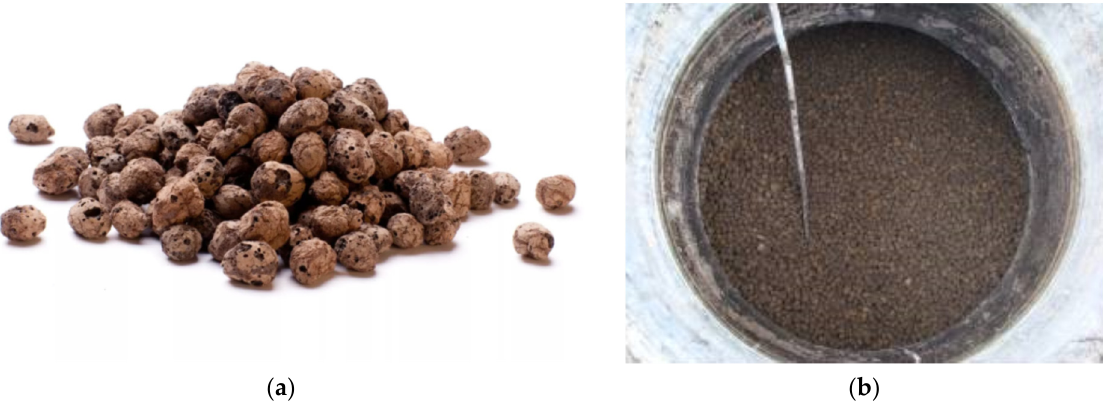
Figure 1. Light expanded clay aggregate used as anaerobic reactor filling in the experimental variant 1 (( a ) general view of the grains; ( b ) LECA in the digester).